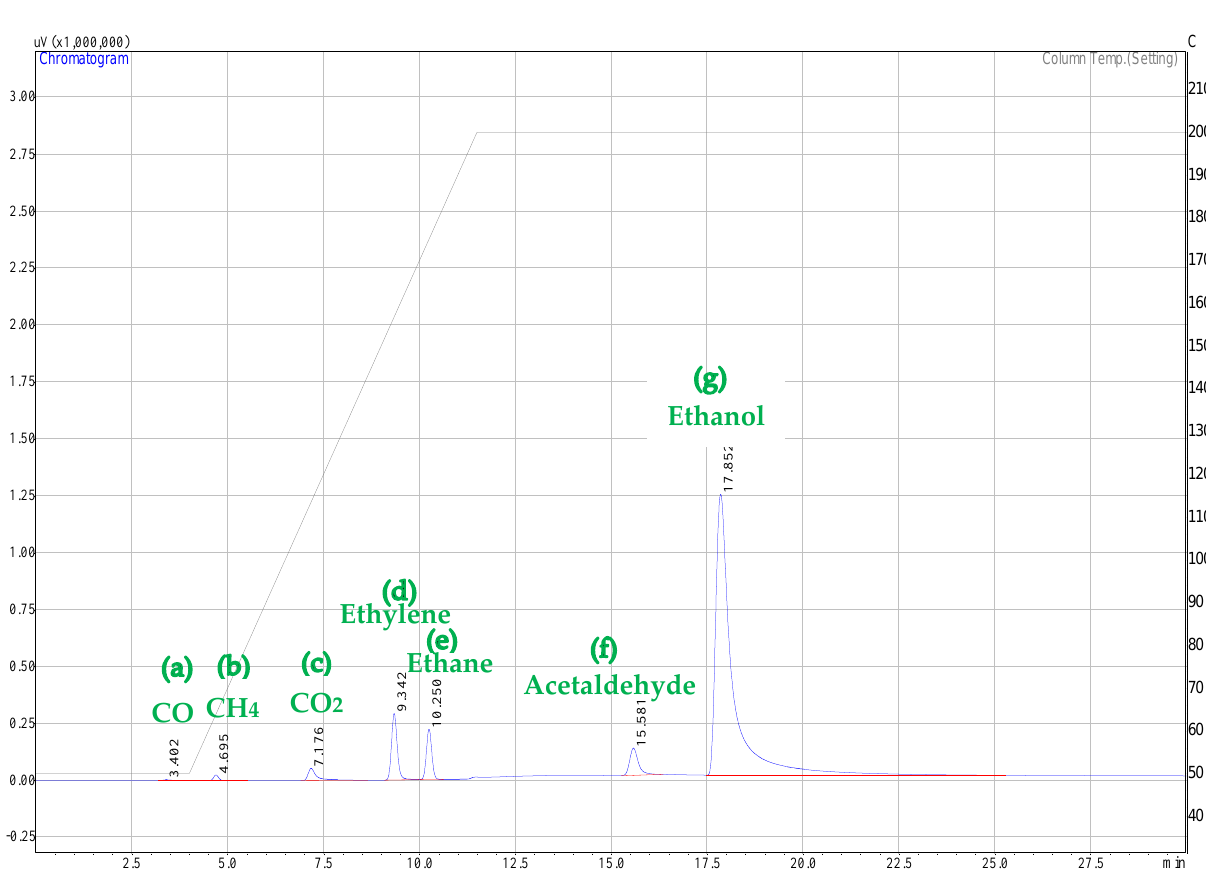
Figure A1. Hydrogen peak as detected by the TCD.